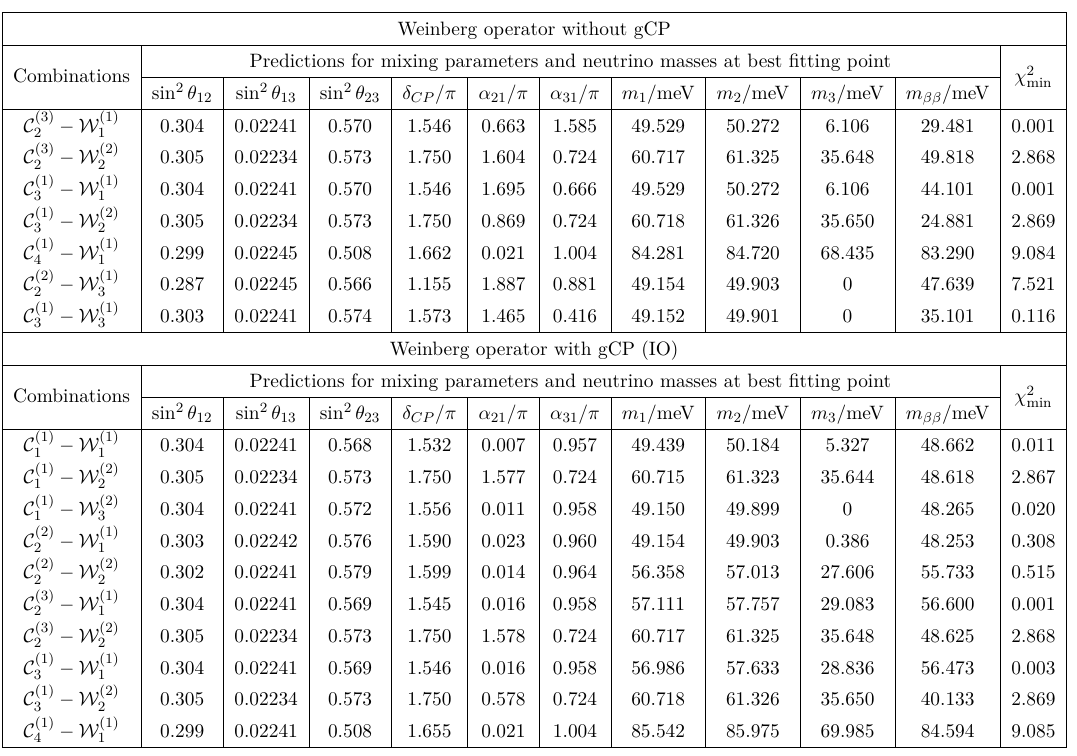
Table 21. The same as in table 19 but for IO neutrino